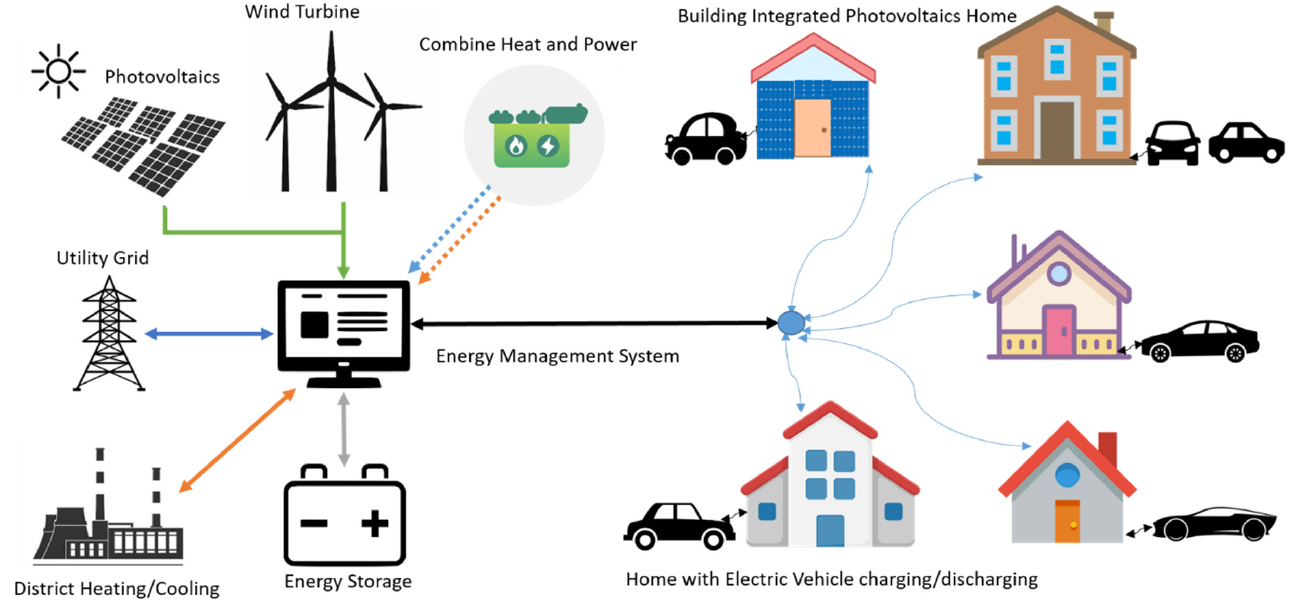
Figure 7. Positive energy community.